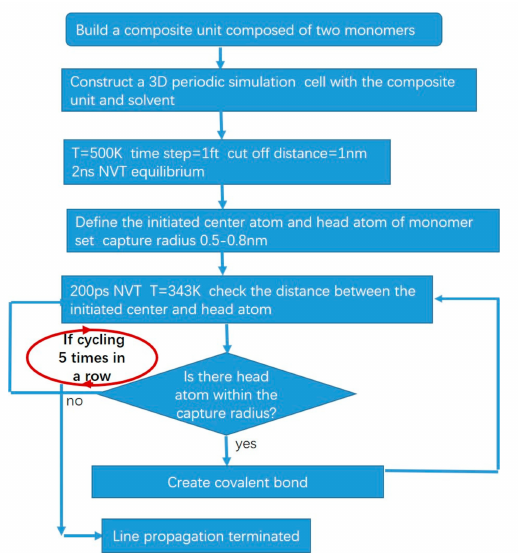
Figure 2. Scheme of molecular dynamics simulation algorithm for self-stable precipitation polymerization.